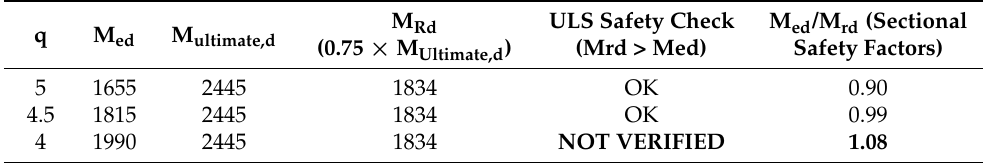
Table 7. Trial and error iterative safety check. Limit-seismic input for response spectrum scaled for q = 4.5.